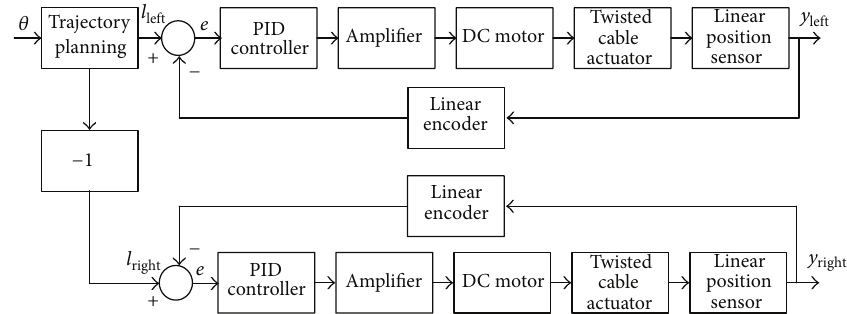
Figure 7: Block diagram of control scheme with regular PID controllers.